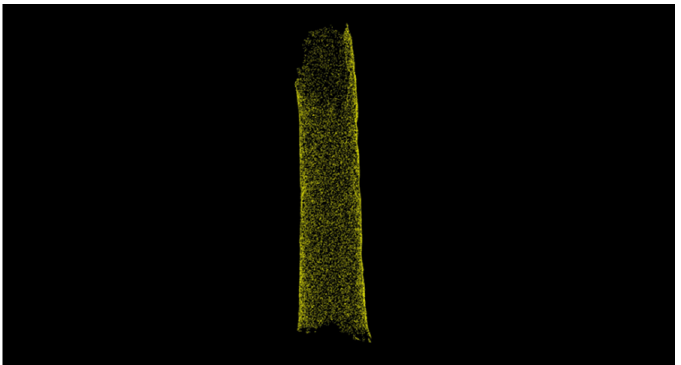
Figure 12. An individual tree in the manual tree selection mode of the 3D Forest software.